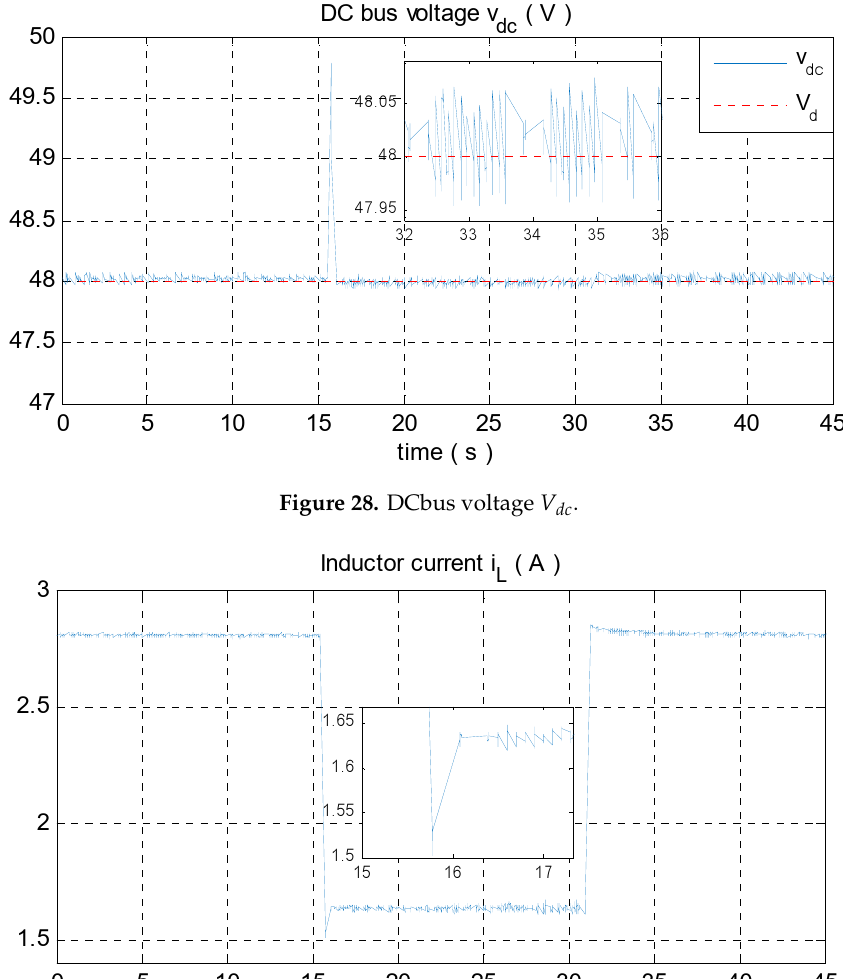
Figure 27. Programmed profile of the load resistance.